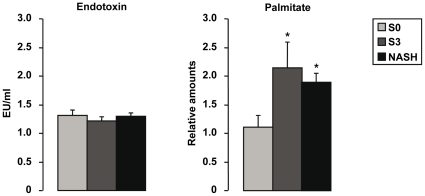
Elevated serum palmitate levels but not endoxin levels were present in severely steatotic obese patients.
A. The serum of 9 lean patients and 70 morbidly obese patients (15 S0 patients, 23 S3 patients and 23 NASH patients with severe steatosis) was used to evaluate the circulating levels of endotoxin. B. The abundances of palmitate as expressed relative to their values in a commercial serum sample (over 1000 individuals) were evaluated in 8 S0 patients, 9 S3 patients and 8 NASH patients.